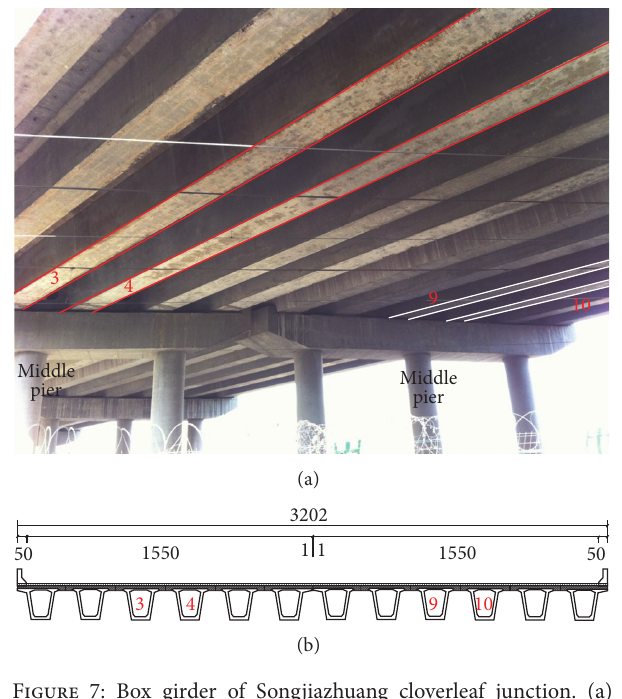
Figure 7: Box girder of Songjiazhuang cloverleaf junction. (a) Photo; (b) profile.